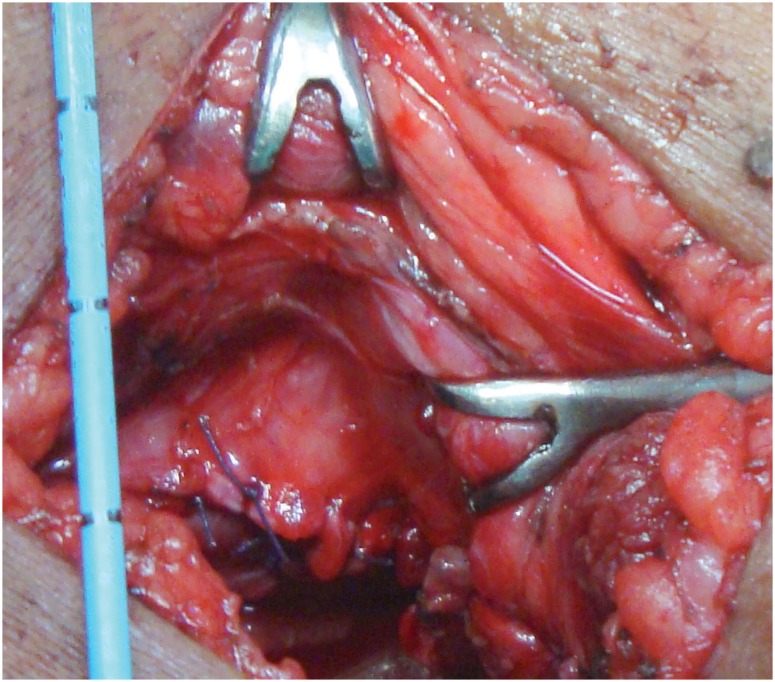
Water-tight anastomosis.